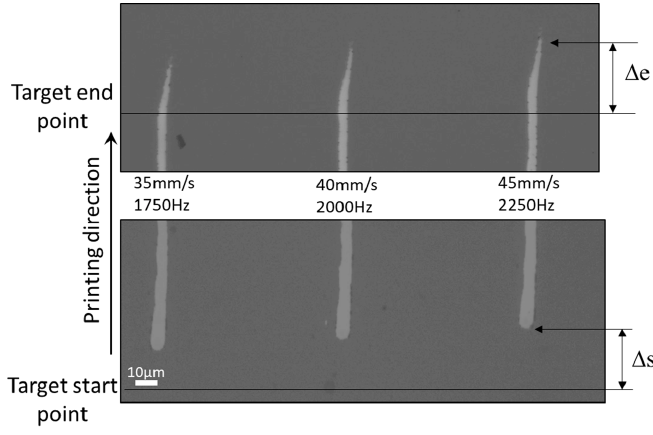
Figure 12. Line printing using the dummy distance ( d 1 , d 2 = 3 mm) function of the EPU with d s = 20 µ m.